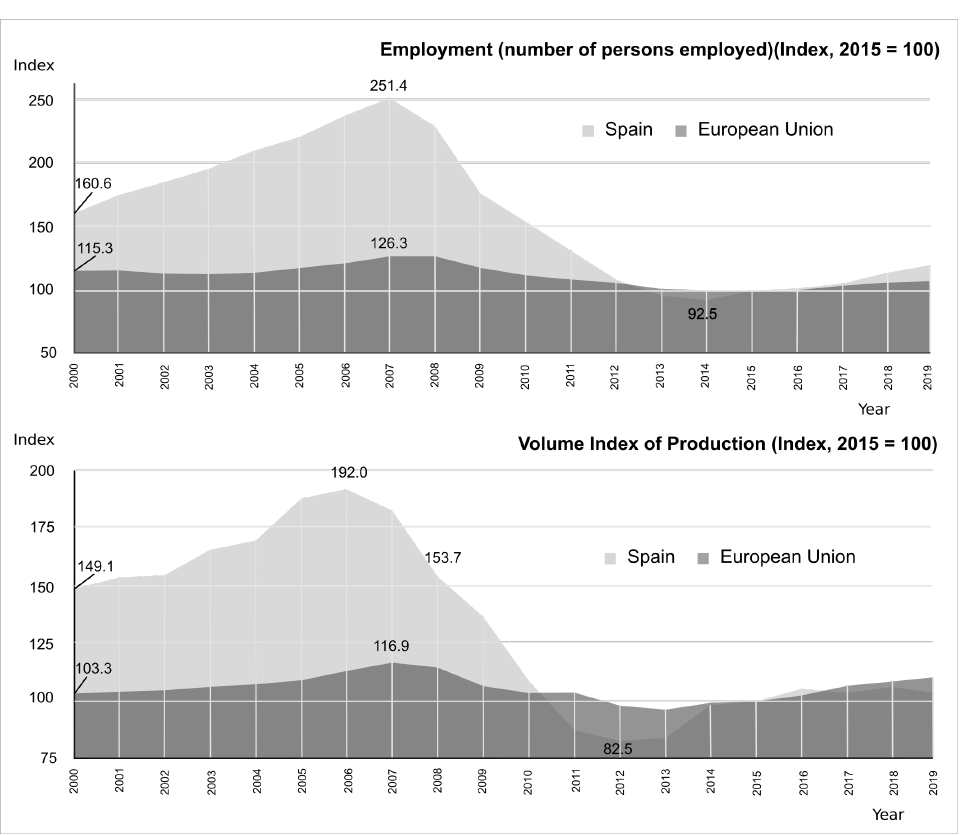
Figure 1. Production and labor input in construction: Eurostat, production in construction (annual data)